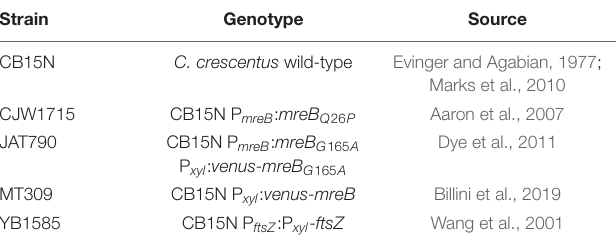
TABLE 1 | Description of all strains used in this